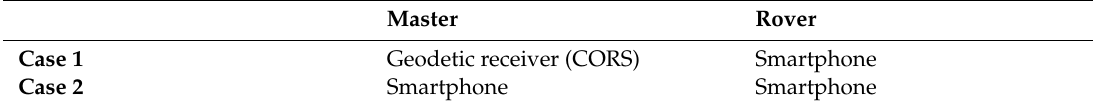
Table 3. Case studies considered in this research